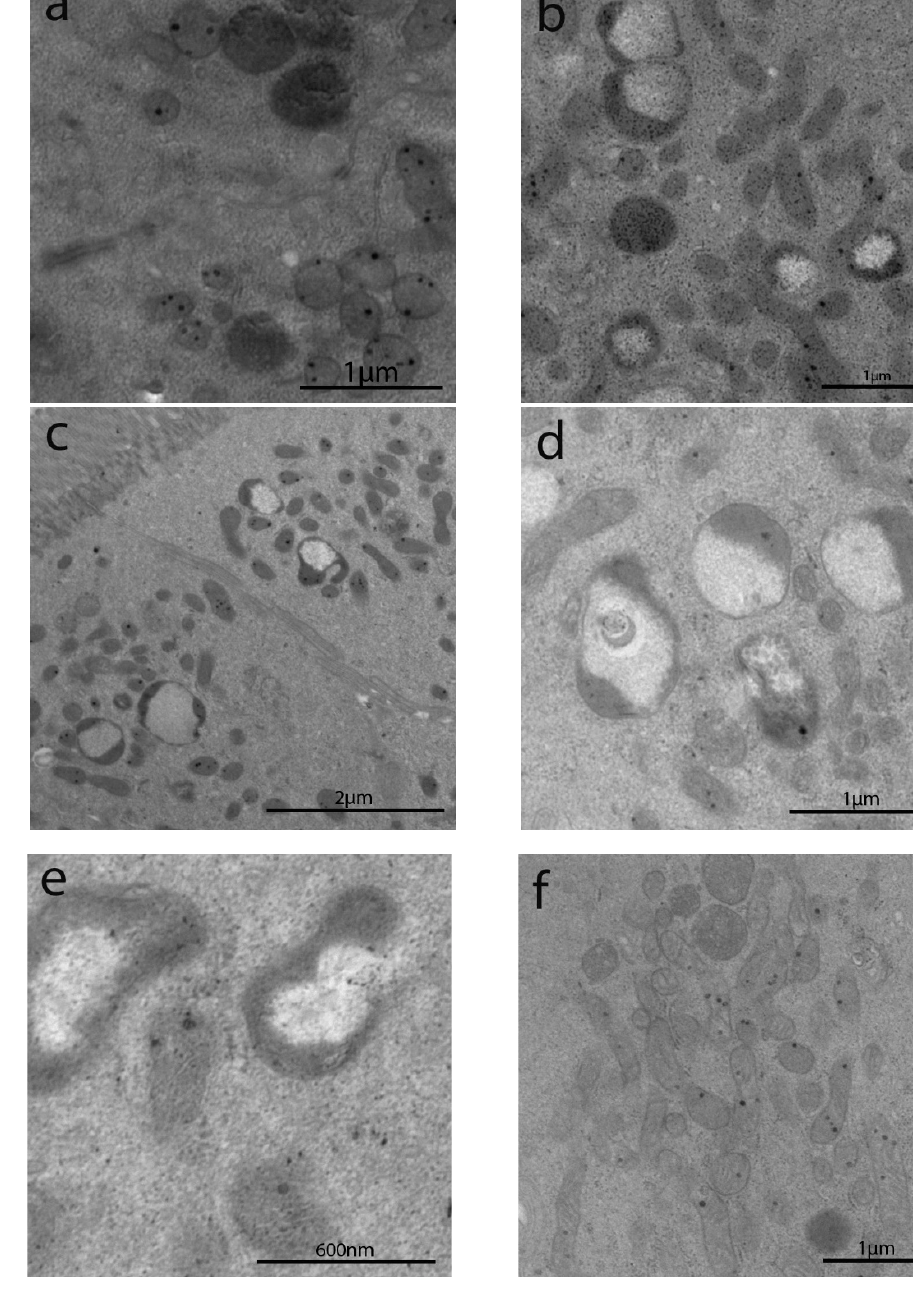
Figure 4. TEM images of autophagic bodies and lysosomal vacuoles in the cytoplasm of enterocytes in IBS-like disorders. Legend: uCD ( a ), tCD ( b ), WA ( c ), NCGS ( d ), Ni ACM ( e ), CTRL ( f ). All pictures ( a – e ) showed increased autophagic bodies, as well as lysosomal vacuoles in the apical cytoplasm, whereas no signs of autophagy have been observed in controls ( f ).